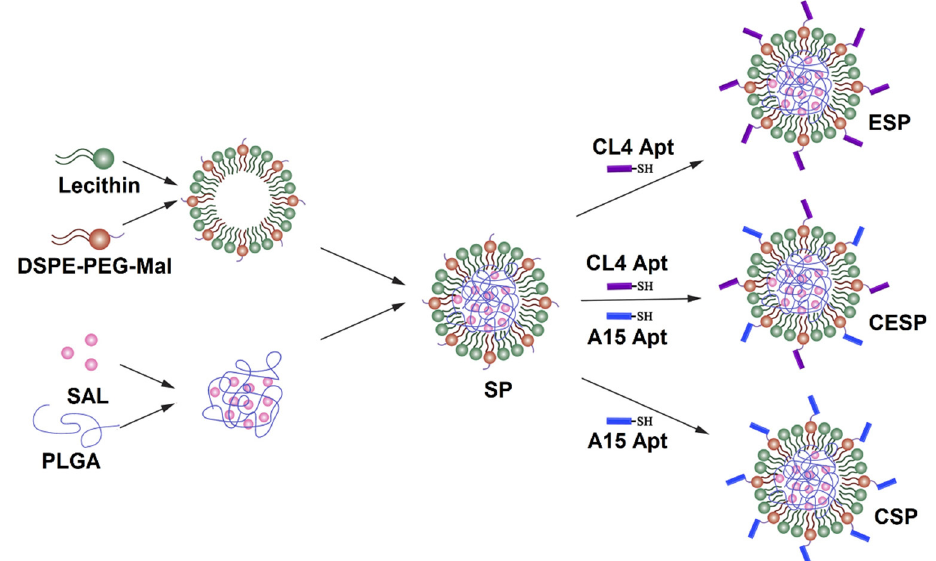
Figure 3. Schematic diagram of the preparation of SLM-loaded LP NPs conjugated with anti-EGFR (ESP), anti-CD133 (CSP), and both anti-EGFR and anti-CD133 (CESP) aptamers. Reprinted with permission from ref. [55], Copyright 2018 Elsevier.